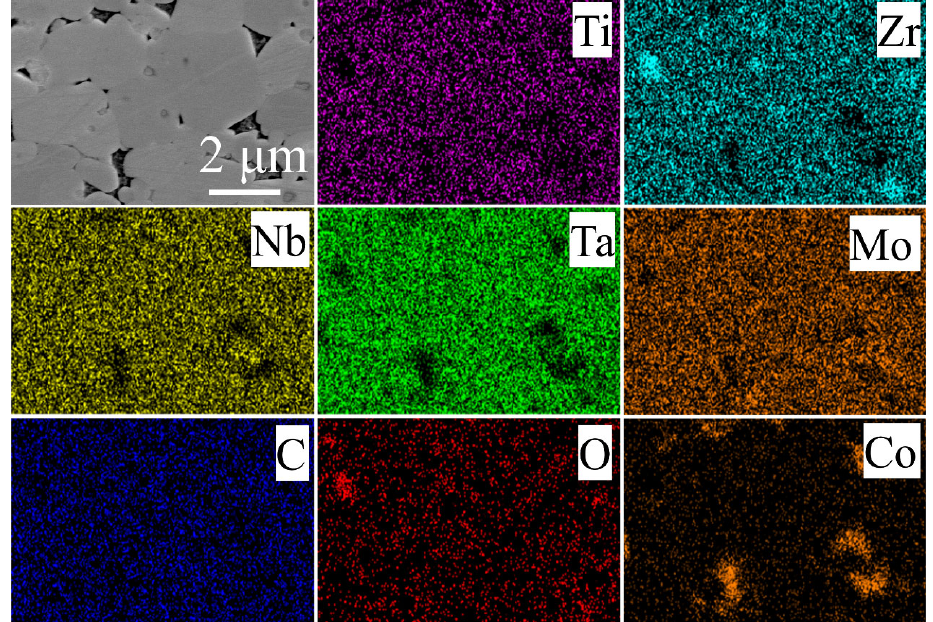
Fig. 6 SEM image of the polished surface for HC1550-L and corresponding elemental composition EDS